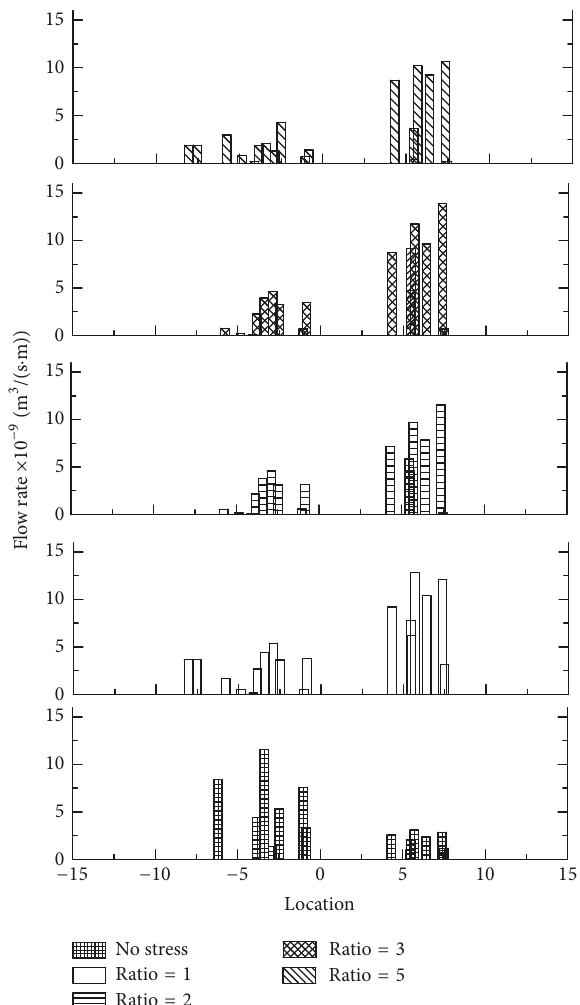
Figure 11: Flow rate distribution of fractures on the bottom outlet